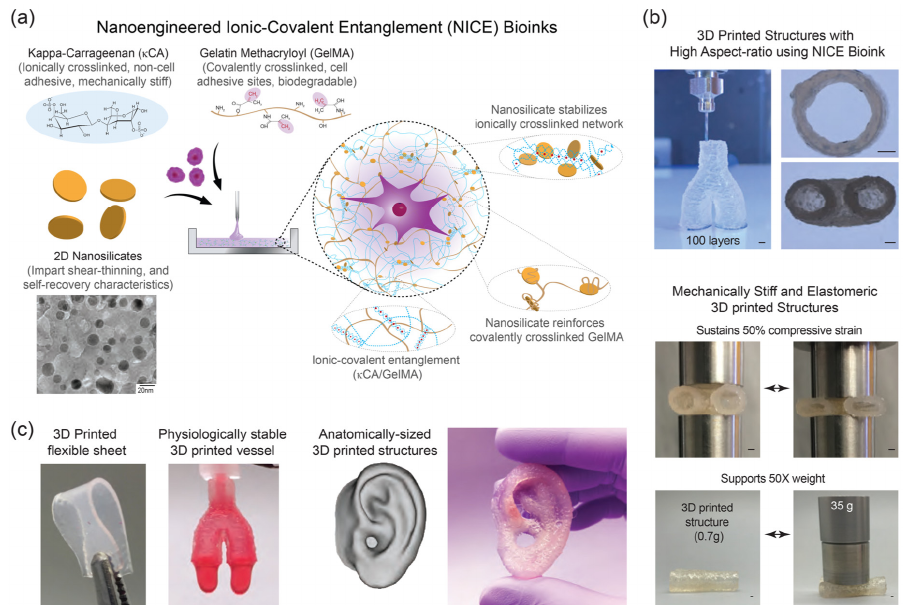
Figure 5. ( a ) Composition of Nanoengineered Ionic-Covalent Entanglement (NICE) cell inks, which employ nanocomposite reinforcement and ionic-covalent entanglement mechanisms to create a cell ink that is elastic, touch, and highly printable. Nanosilicates are used to reinforce an ionic- covalent entanglement hydrogel made from GelMA and κ CA. These interactions allow the NICE bioink to behave as a solid at low shear stresses and improve shear thinning characteristics during bioprinting. Lower left: TEM imaging of two-dimensional nanosilicate particles show uniform morphology. ( b ) Examples of free-standing, tall structures using NICE bioink. Scale bar = 1 mm. Crosslinked structures are stiff and elastomeric, and can support more than 50-times their own weight. ( c ) Examples of structures printed using NICE cell ink that emulate anatomical structures, and are mechanically and physiologically stable and exhibit high structural fidelity. Reproduced e with permission from [123], the American Chemical Society,